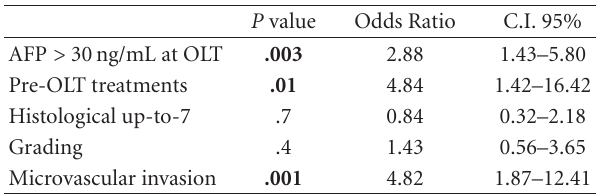
Table 3: Multivariate analysis of factors a ff ecting recurrence-free survival after OLT in patients with